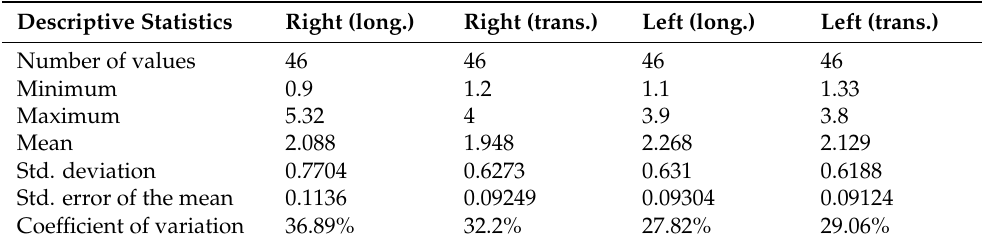
Table 2. Ultrasound thickness measurements of the thoracolumbar fascia at the L3 level of the lumbar spine in chronic non-specific LBP patients. Abbreviations: long. = longitudinal scan; trans. = transversal scan.